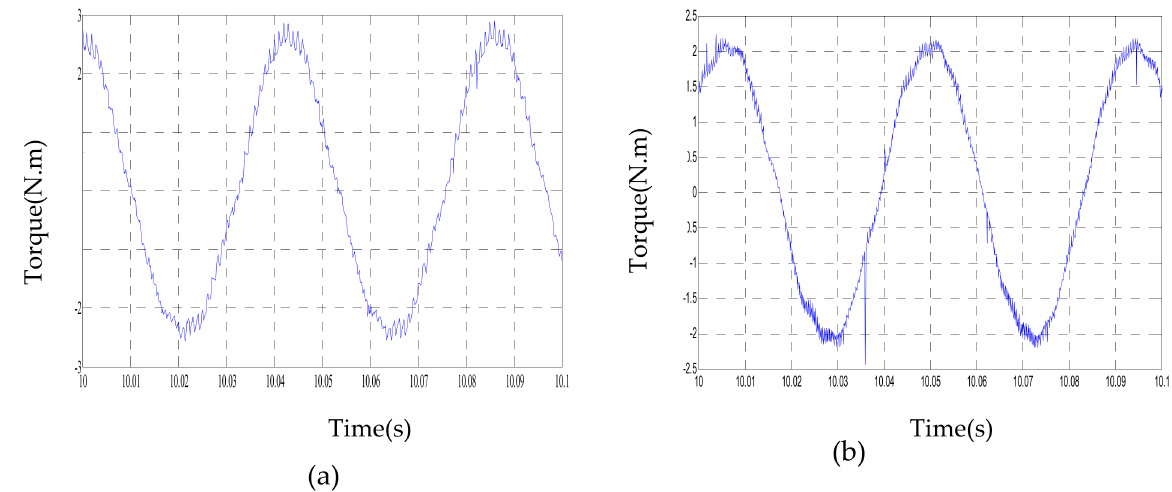
Figure 15. C omparison between ( a ) 2L_FOC and ( b ) 3L_FOC in open and closed loop Figure 15. Comparison between ( a ) 2L_FOC and ( b ) 3L_FOC in open and closed loop conditions in conditions in terms of Current distortions. terms of Current distortions.